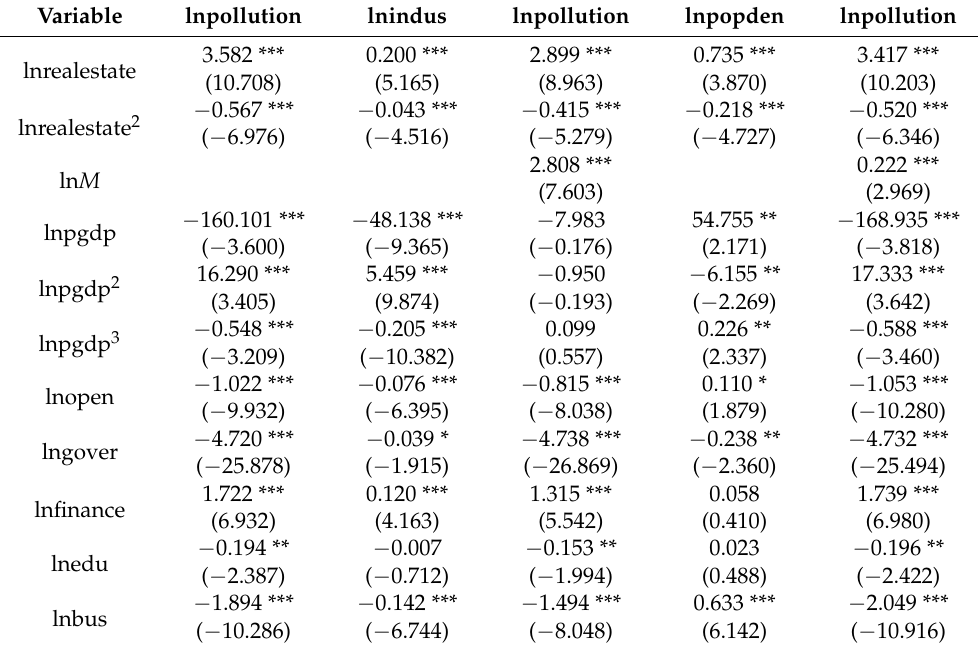
Table 7. Regression results of Spatial Mediation